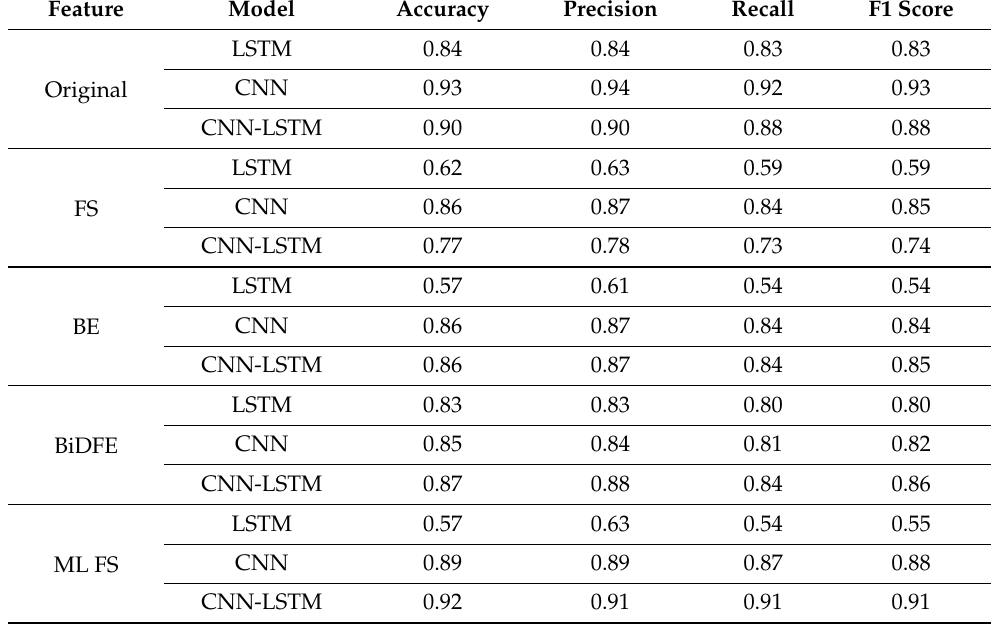
Table 16. Deep learning models results with each feature selection